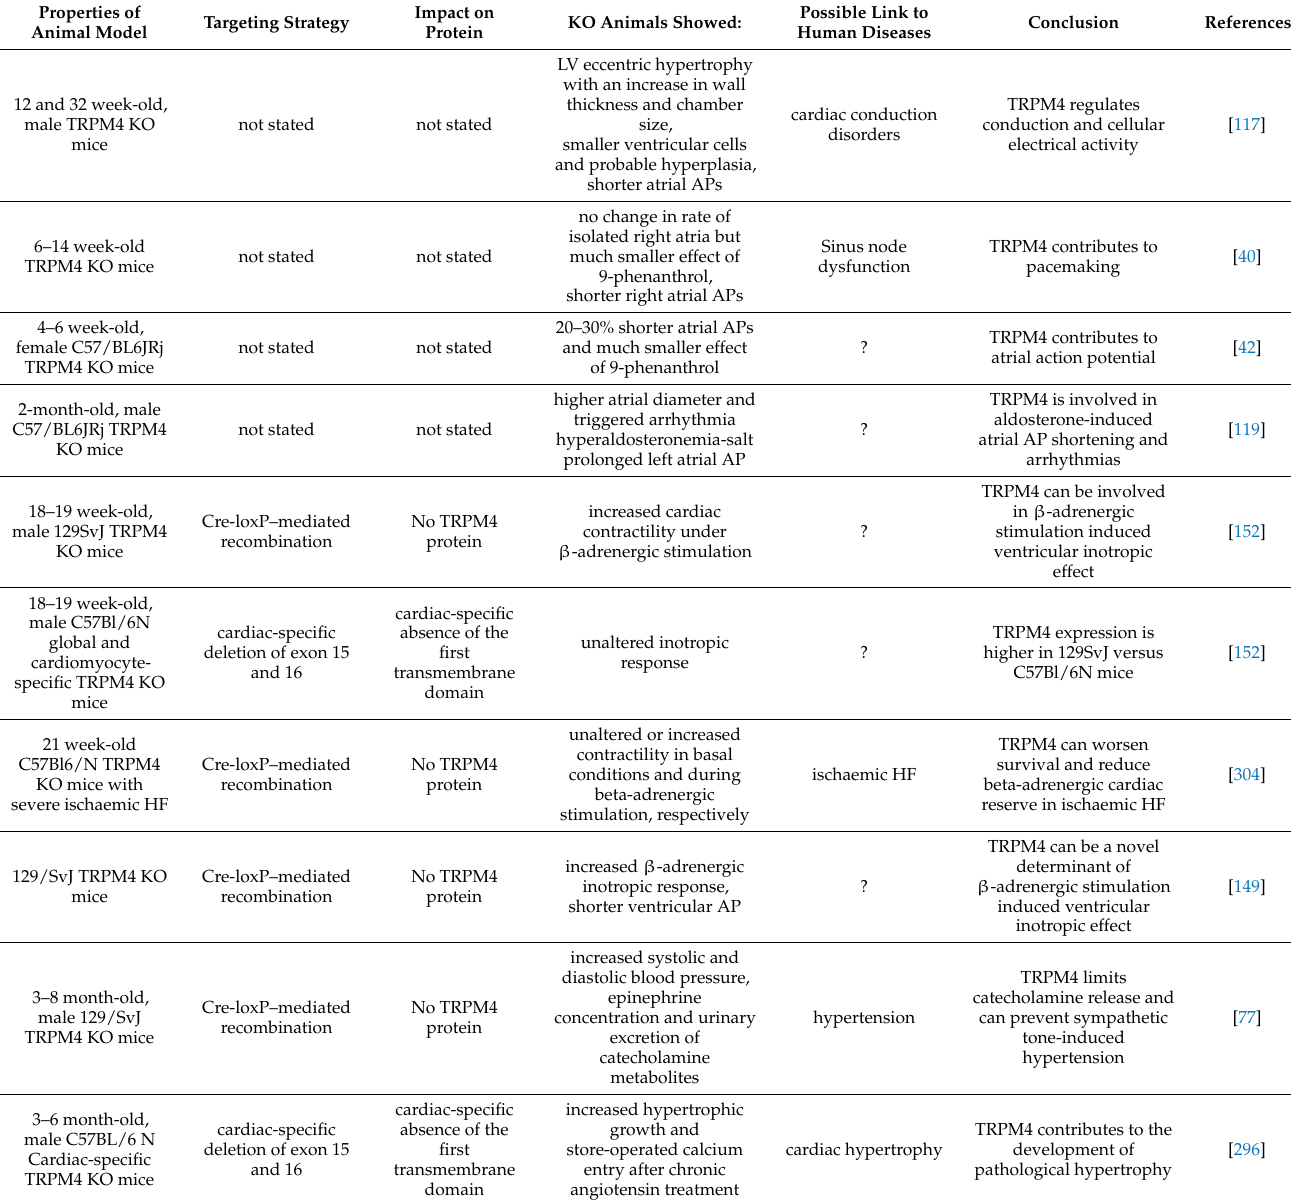
Table 4. Summary of murine cardiac TRPM4 KO animal